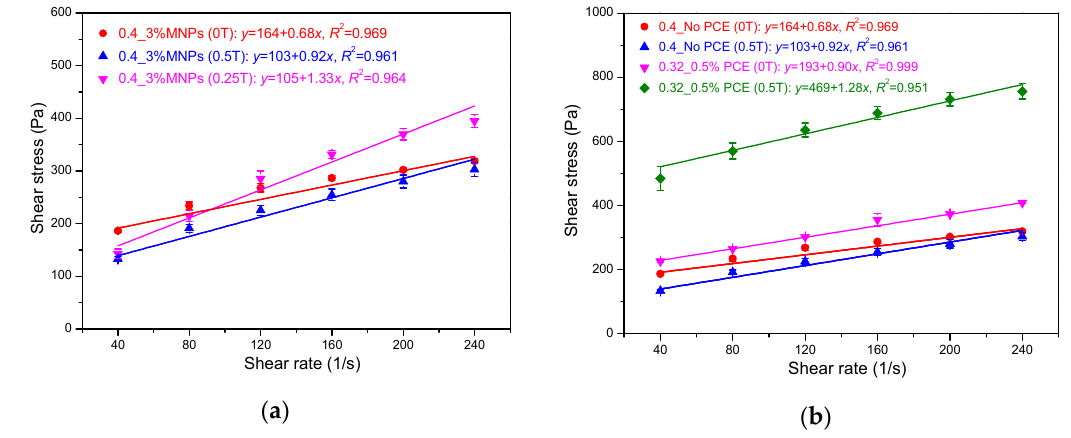
Figure 9. Effect of ( a ) various magnetic fields and ( b ) paste mediums on the flow curve.